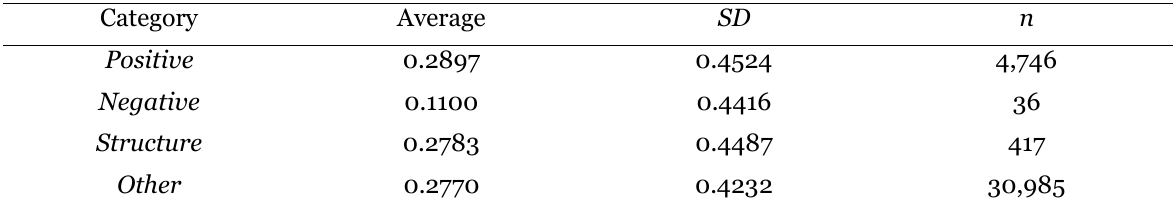
Average and Standard Deviation of Compound Sentiment Scores by